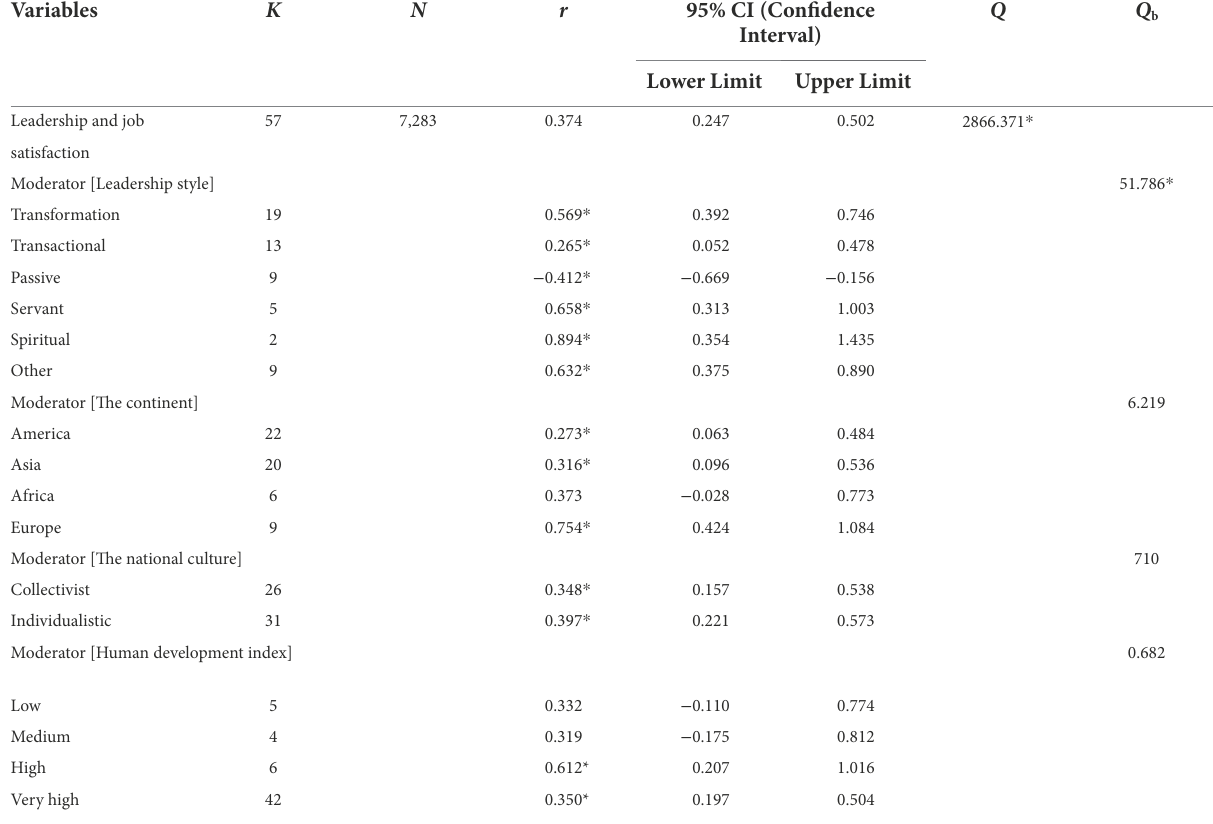
TABLE 2 Meta-analysis results related to relationship between leadership in HEIs and academic staff’s job satisfaction.